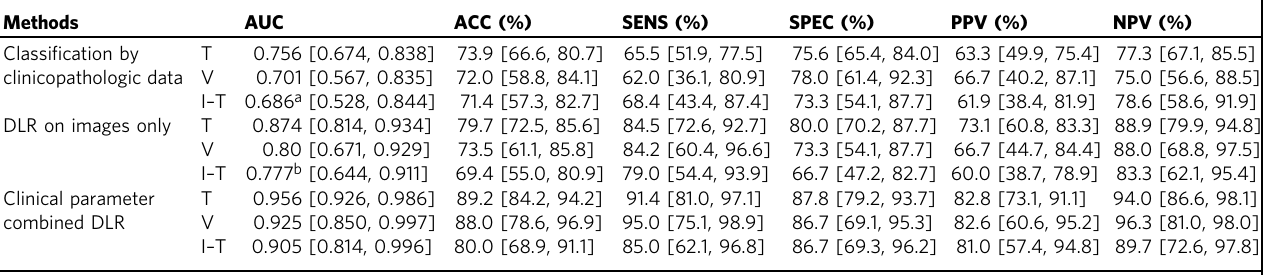
95% con fi dence intervals are included in brackets. Source data are provided as a Source Data fi le. AUC area under the receiver operating characteristic curve, ACC accuracy, SENS sensitivity, SPEC speci fi city, PPV positive predict value, NPV negative predict value, DLR deep learning radiomics, T training cohort (n = 148), V validation cohort ( n = 49), I – T independent test cohort ( n = 50). a Indicates P = 0.03, Delong et al. in comparison with clinical parameter combined DLR in independent test cohort. b Indicates P = 0.04, Delong et al. in comparison with clinical parameter combined DLR in independent test cohort. Source data are provided as a Source Data fi le.